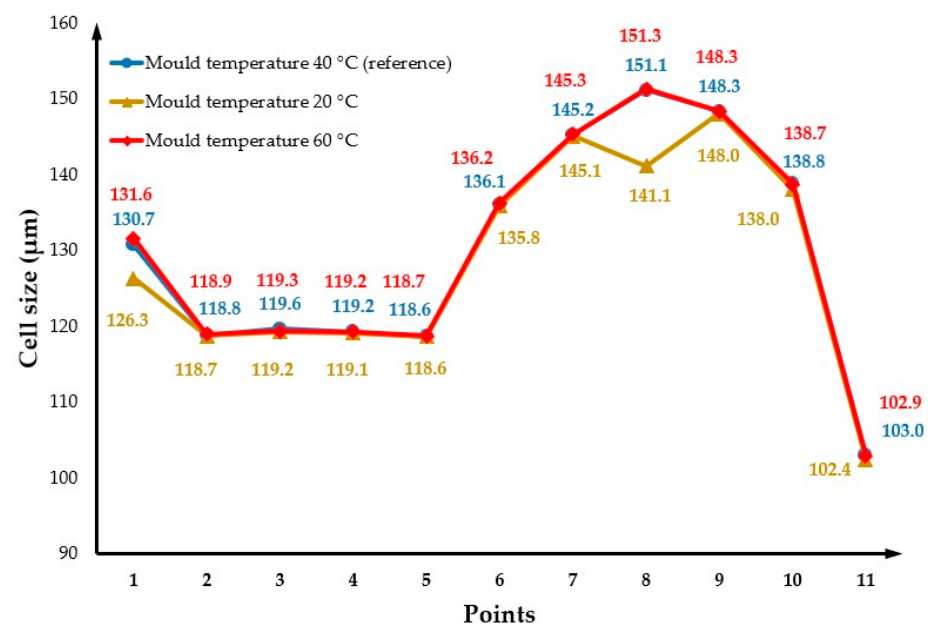
Figure 7. Cross-section variation in cell size as a function of mould temperature.